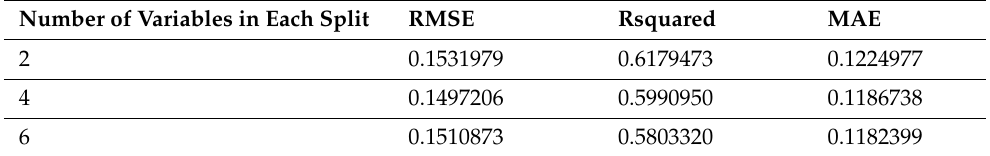
Table 6. Random Forest